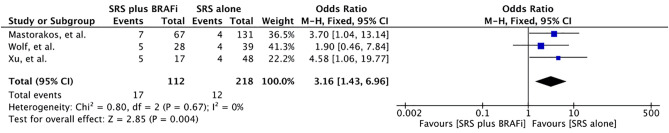
Forest plot of meta-analysis of intracranial hemorrhage (ICH) for treatment comparison [BRAF inhibitors plus stereotactic radiosurgery (SRS) vs. SRS alone] in the management of melanoma brain metastases (MBM).